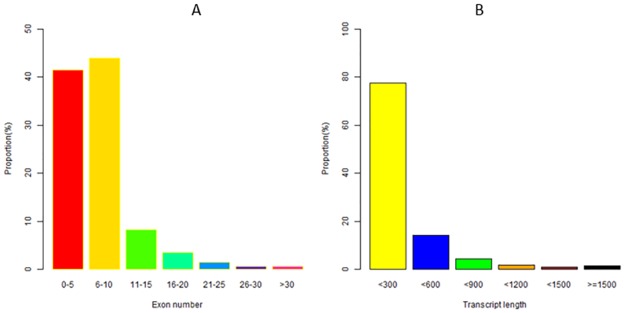
The length and exon number of transcripts.